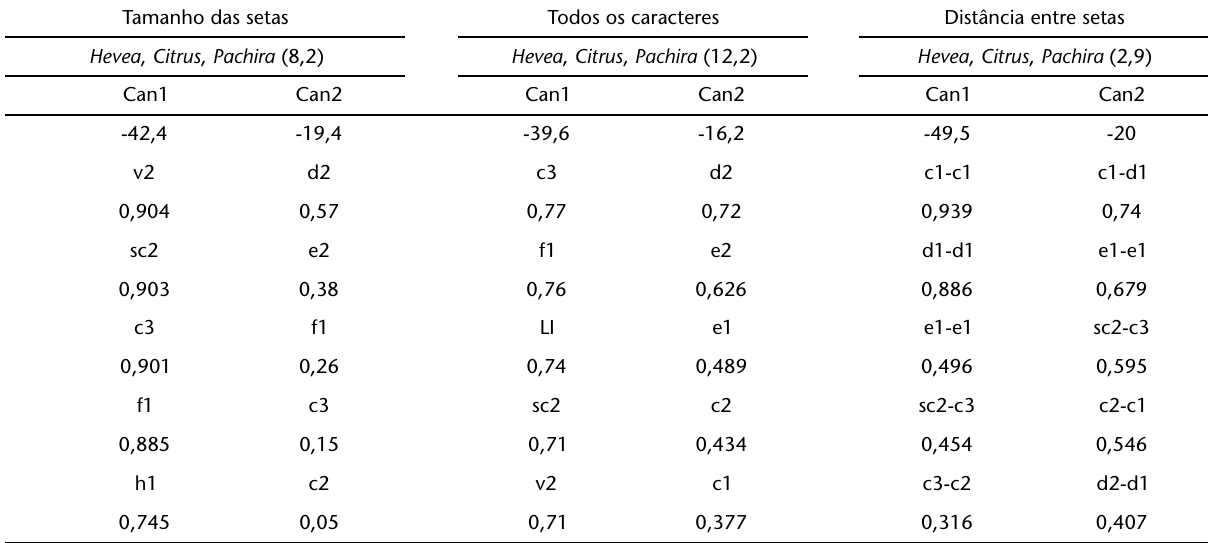
Tabela III. Resultados da análise das Variáveis Canônicas de 29 caracteres (tamanho de corpo e de setas dorsais do idiossoma; distância entre as setas) de fêmeas de mesmas populações de E . banksi . Proporção da variação total explicada conjunta e isoladamente pelas duas principais variáveis canônicas sobre a variação total das populações analisadas (%) para combinações de três populações; caracteres morfológicos que influenciaram as cinco primeiras variáveis canônicas e seus respectivos pesos, em ordem decrescente de valor absoluto. Tamanho das setas